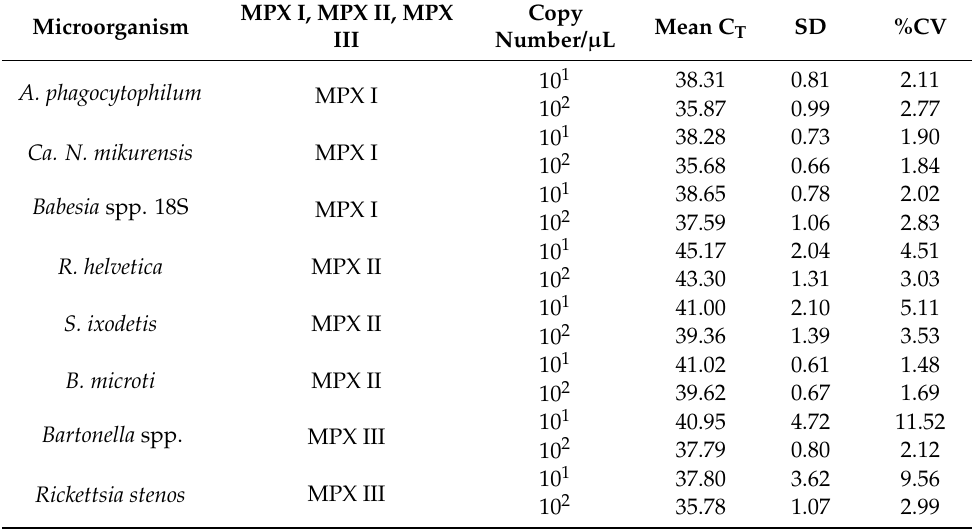
Table 5. Repeatability in two different concentrations of the positive control DNA of the eight